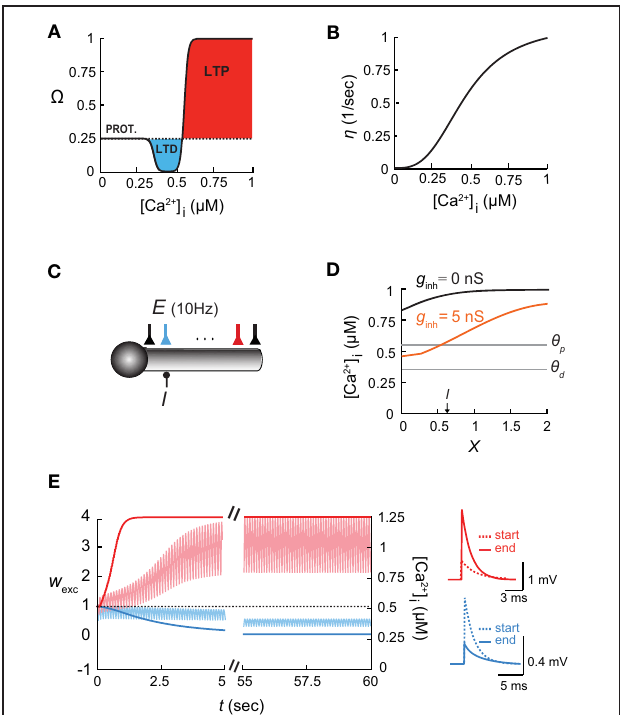
FIGURE 1 | The [Ca 2 + ] i -based learning rule and the shaping of the [Ca 2 + ] i spatial profile in dendrites by inhibition. (A) The plasticity function, (cid:6) , depends on intracellular calcium concentration, [Ca 2 + ] i . Below θ d , the synaptic weights stay at a basal level (PROT. = protected); for θ d < [Ca 2 + ] i < θ p , the synapse undergoes long term depression, LTD; above θ p , it undergoes long term potentiation, LTP. (B) The learning rate η as a function of intracellular calcium (adapted from Shouval et al., 2002). (C) Model of a somatic compartment coupled to a 2 λ long cylindrical cable with inhibitory input ( I ) at X = 0 . 6 and 21 excitatory (AMPA/NMDA-receptor-mediated) synapses activated synchronously at 10Hz each (E) . Cyan and red excitatory synapses located at X = 0 . 6 and X = 1 . 6, respectively. (D) Intracellular calcium concentration along the dendritic cable in the absence of inhibition (black) and with a steady 5nS inhibition (orange). The thresholds for potentiation ( θ p ) and depression ( θ d ) are marked by horizontal lines. (E) Left: Time course of changes in synaptic weights ( w exc ) and [Ca 2 + ] i for distal and proximal excitatory synapses [cyan and red, respectively; colors correspond to the synapses in (C) ] throughout 60s of simulation. Right: EPSPs of the two synapses at the beginning (dashed line) and the end (filled line) of the